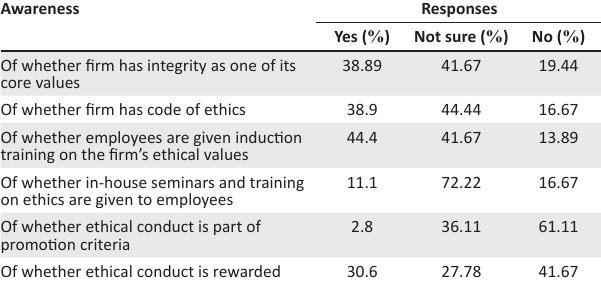
TABLE 6: Employees’ perception of the organisational ethics environment.